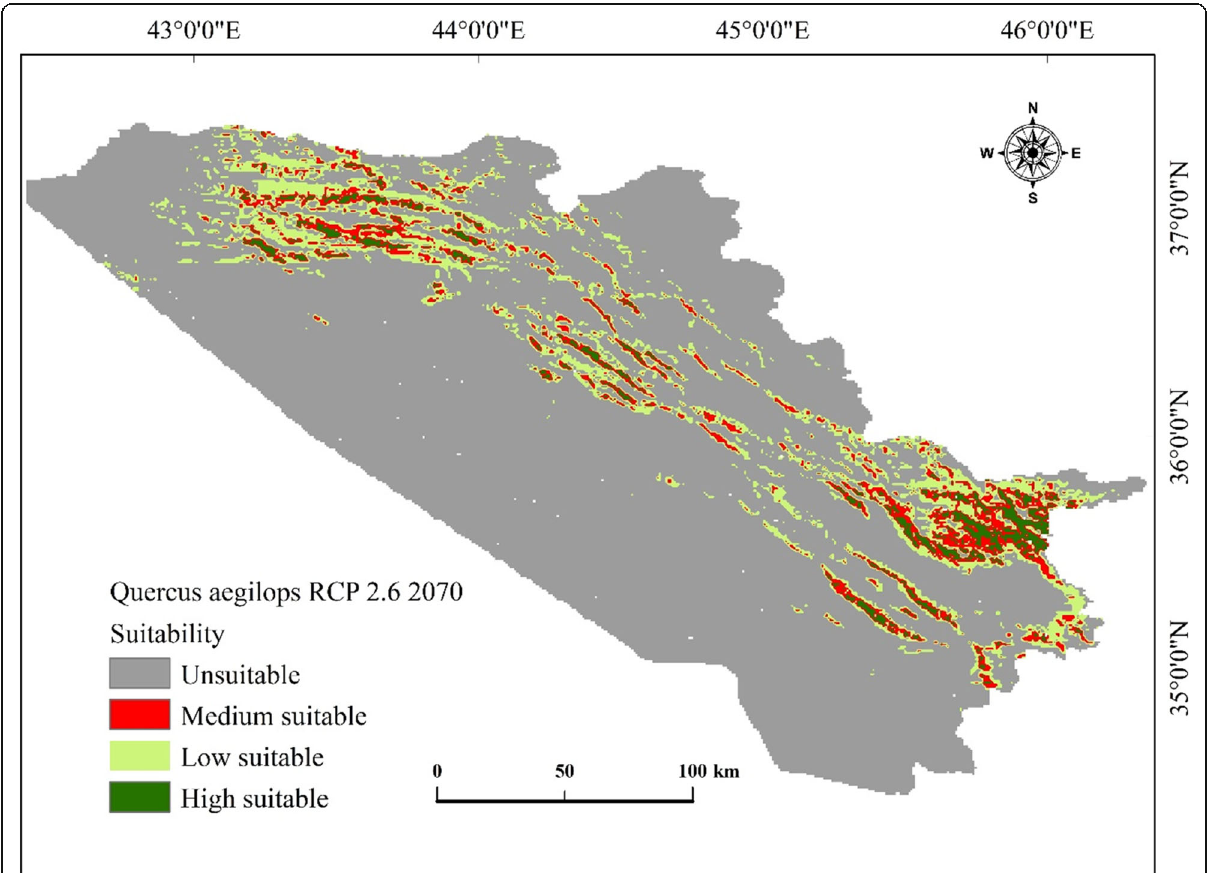
Fig. 3 Future (2070) habitat suitability distribution of Q. aegilops modeled with the selected environmental predictors and presence records under the RCP 2.6 2070 climate change